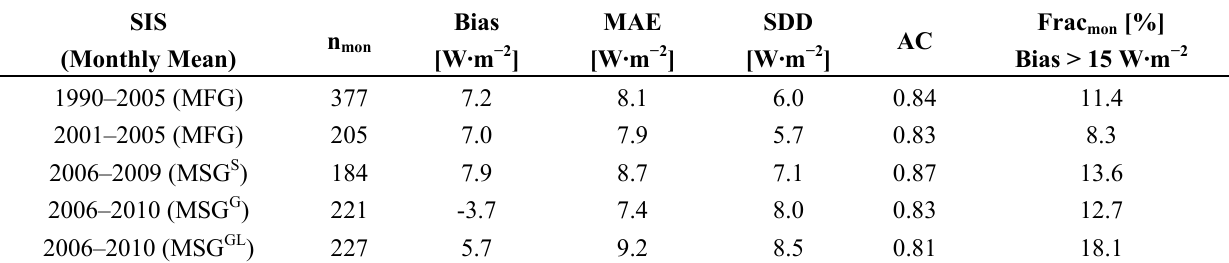
Table 3. Comparison of monthly SIS between CM SAF and BSRN measurements for different time periods and three algorithms used for the extension of the CM SAF series after 2005. Anomalies refer to the period